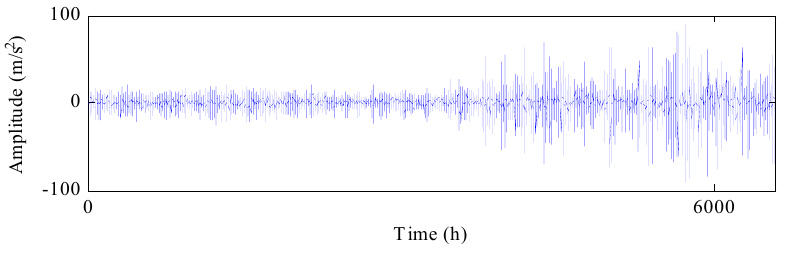
Figure 7. The schematic diagram of WT. Materials 2017 , 10 , 675